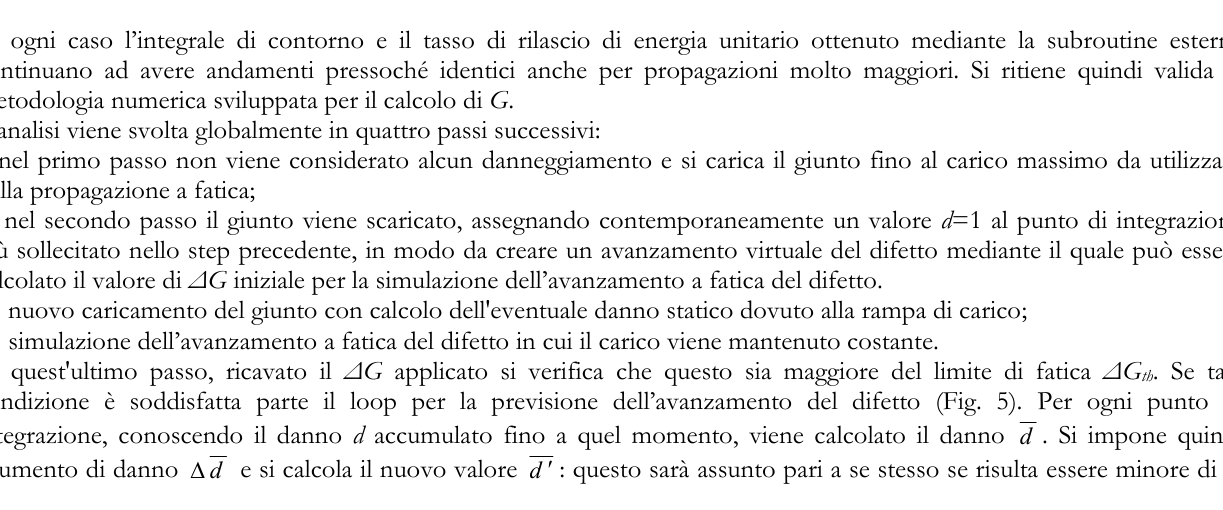
Figura 4: Valori di G calcolati mediate la subroutine e l’Eq. (13) in funzione all’avanzamento del difetto, confrontati con